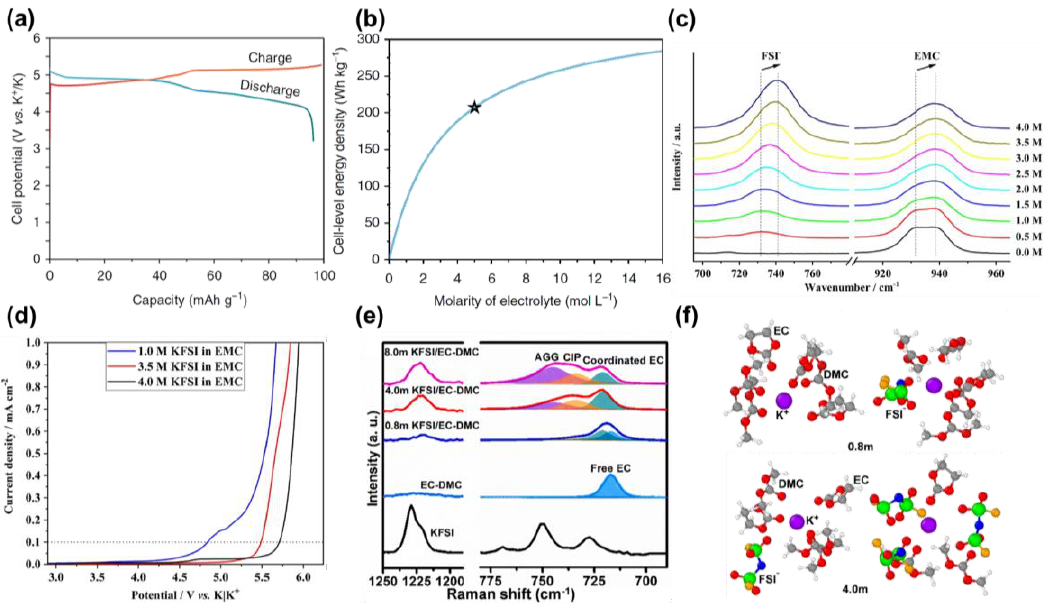
Figure 3. ( a ) Voltage profiles of KFSI − graphite P-DIB within 3.2 – 5.25 V; ( b ) Relationship between cell-level energy density and molarity of KFSI/EC-DMC electrolytes (The star represents the as-selected concentration, i.e., 5.0 M KFSI in EC/DMC (1:1, v / v )). Reprinted with permission from Ref.